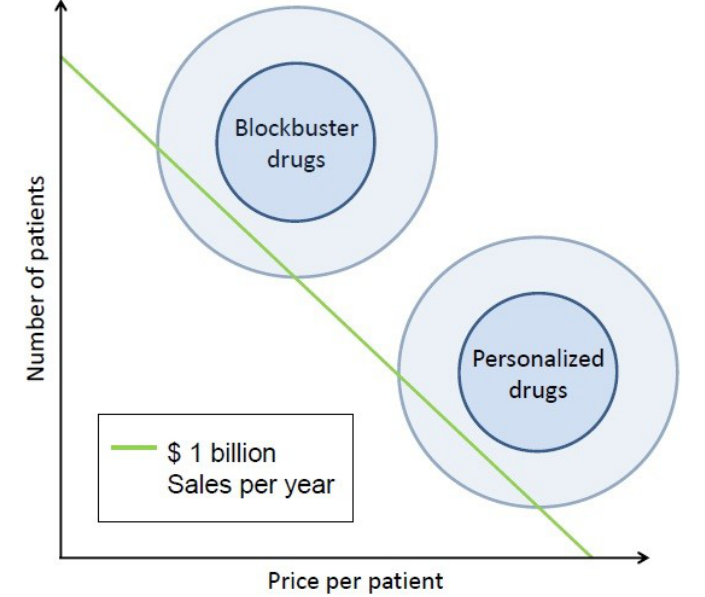
Figure 1. Volume-based revenues of traditional blockbuster drugs vs . margin-based revenues of personalized medicine